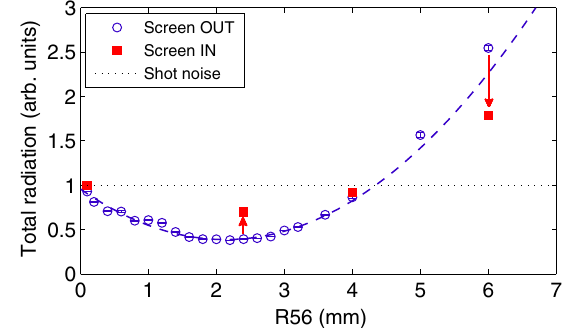
FIG. 4. Intensity on the camera as a function of chicane R 56 at − 14 deg phase with OTR screen OUT (blue circles) and screen IN (red squares). The dotted black line shows the inferred shot noise level. The screen shifts intensity towards the shot noise level, but does not fully suppress coherent